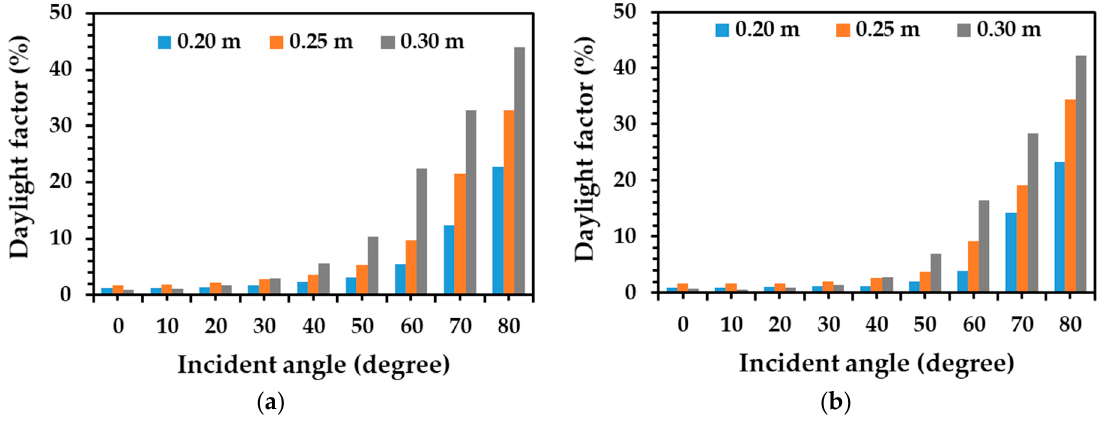
Figure 16. Daylight factor of the vertical light tube using ( a ) aluminum alloy and ( b ) zinc alloy.